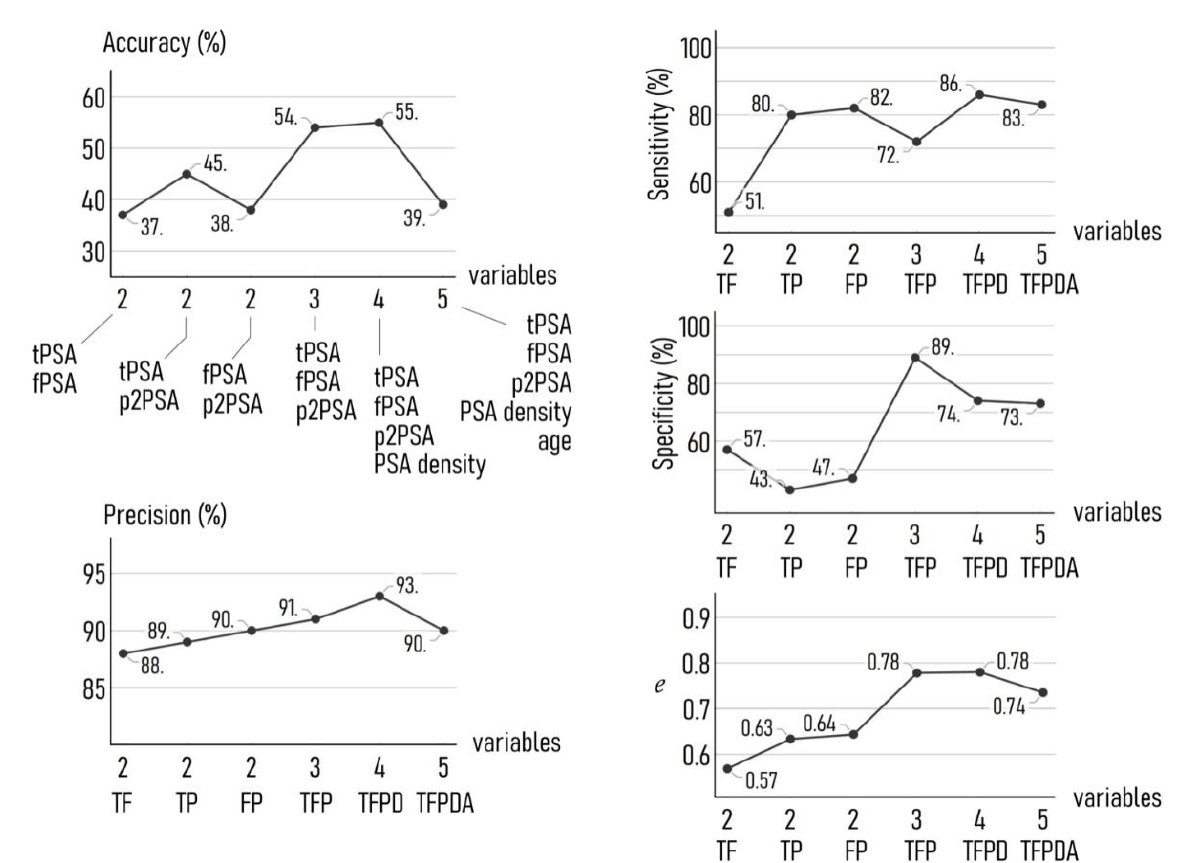
Figure 5. We measured the performance of the model using 4 different metrics, i.e., accuracy (A), sensitivity (Se), specificity (Sp), and precision (P). The error ( e ) is the mean of these 4 metrics. We report in the diagrams the values of A, Se, Sp, P, and e determined for the AI model receiving as an input different combinations of the clinical variables used in the study plus age. The model achieved maximum efficiency using as input variables: tPSA, fPSA, p2PSA, and PSA density.